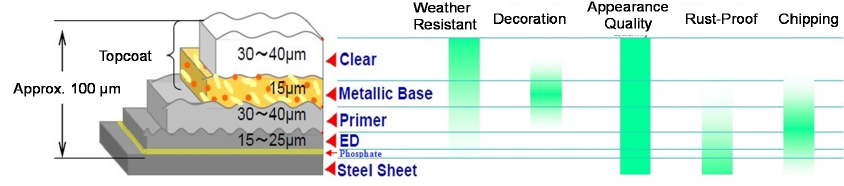
Figure 2. Automotive coating layers, their thicknesses and purposes for an exterior surface.